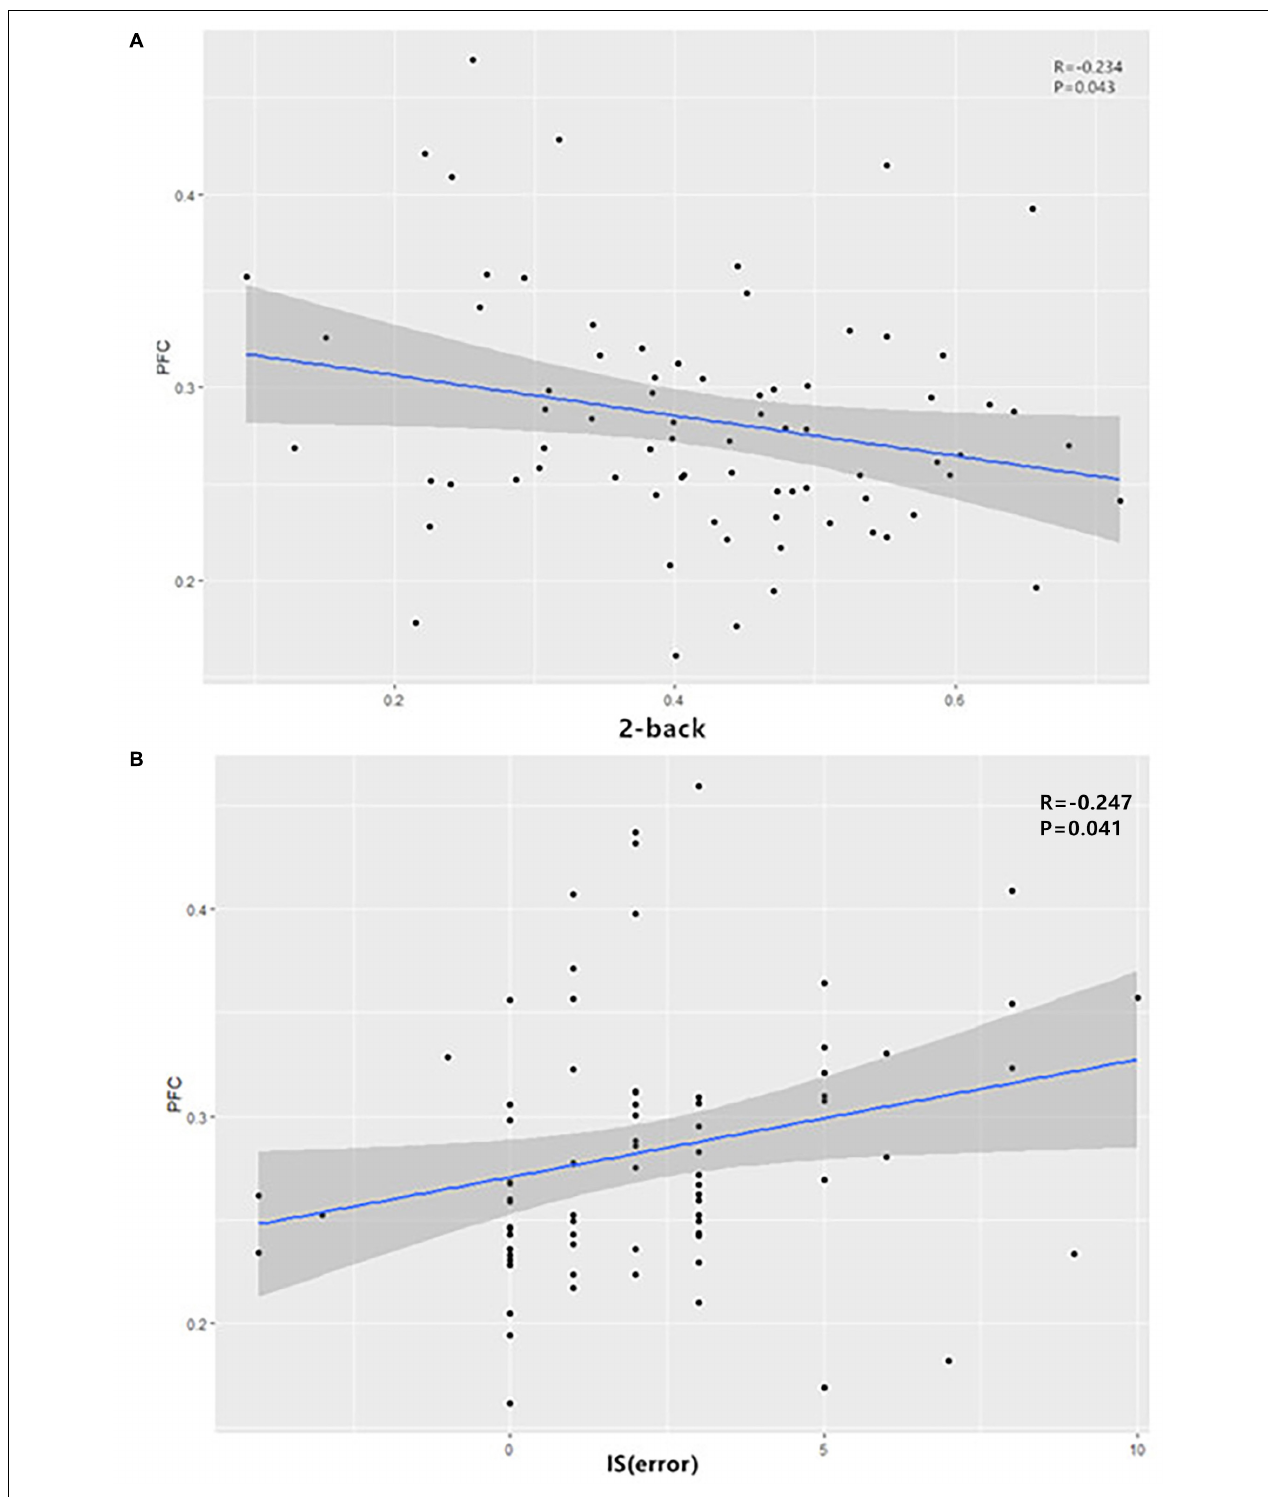
FIGURE 2 | In ADHD patients, the dFC between the right SFA and the right PFC showed (A) a negative correlation with the 2-back scores and (B) a positive correlation with IS (error). ADHD, attention-deficit/hyperactivity disorder; dFC, dynamic functional connectivity; IS, interference score; SFA, superficial amygdala.